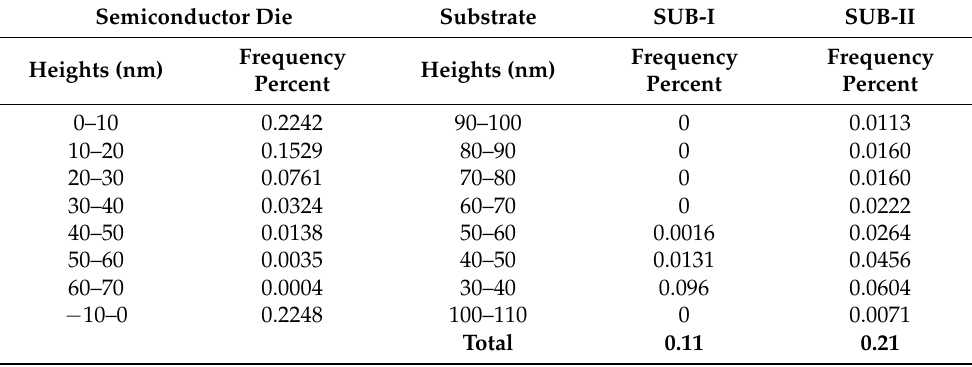
Table 2. Frequency percent distribution of surface roughness